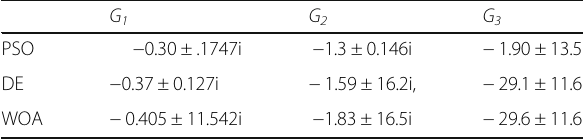
Table 4 Eigen value analysis with PSO,DE and WOA